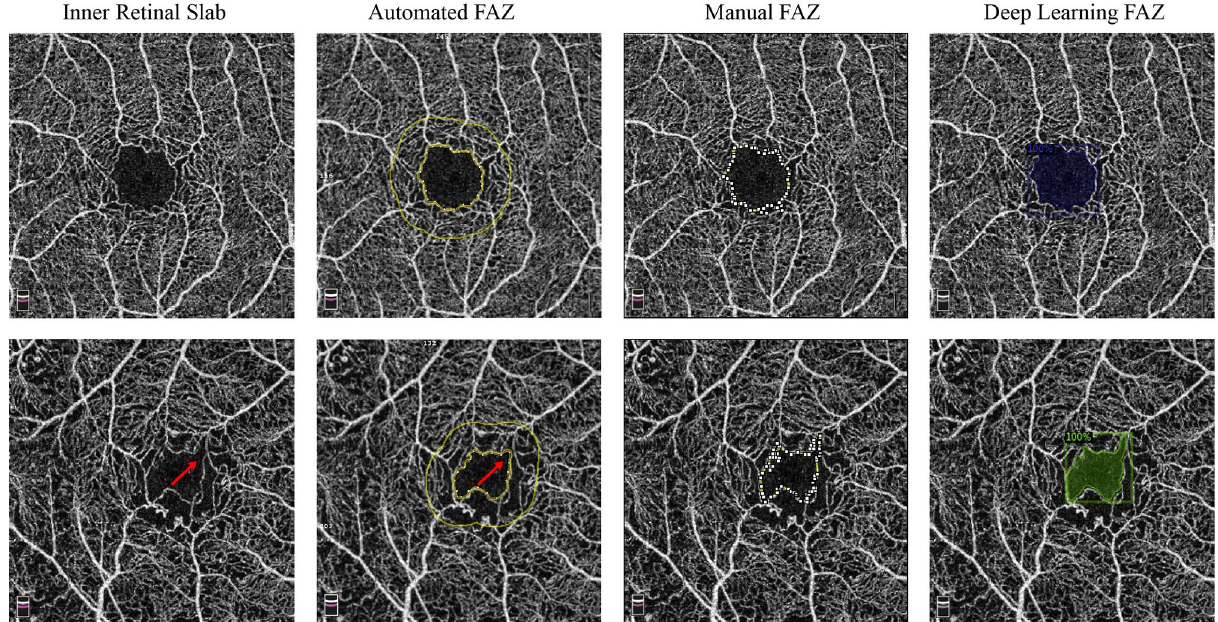
Figure 5. First row: the foveal avascular zone (FAZ) area measurements in a healthy subject were 0.337 mm 2 , 0.346 mm 2 and 0.344 mm 2 using automated, manual and deep learning methods, respectively. Second row: The foveal avascular zone (FAZ) area measurements in a diabetic patient were 0.219 mm 2 , 0.250 mm 2 and 0.249 mm 2 using automated, manual and deep learning methods, respectively. Note that the drawn line made by the built-in software (Red arrow) gives a false impression of correct FAZ delineation. (Python Software Foundation. Python Language Reference, version 3.6. Available at http://www.pytho